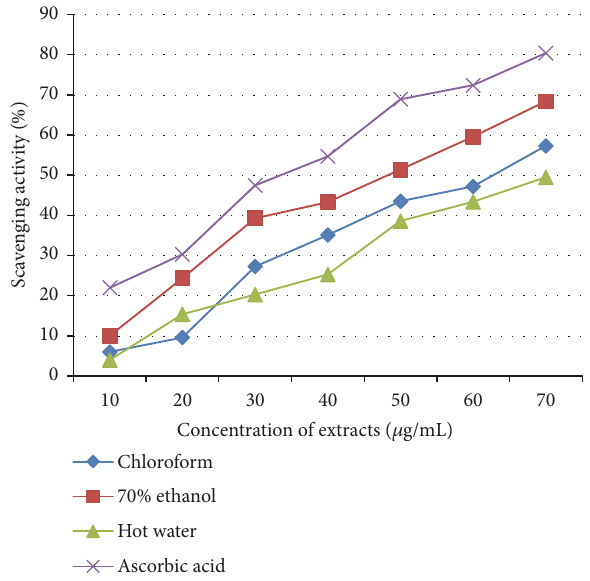
Figure 4: Free radical scavenging activity of Termitomyces